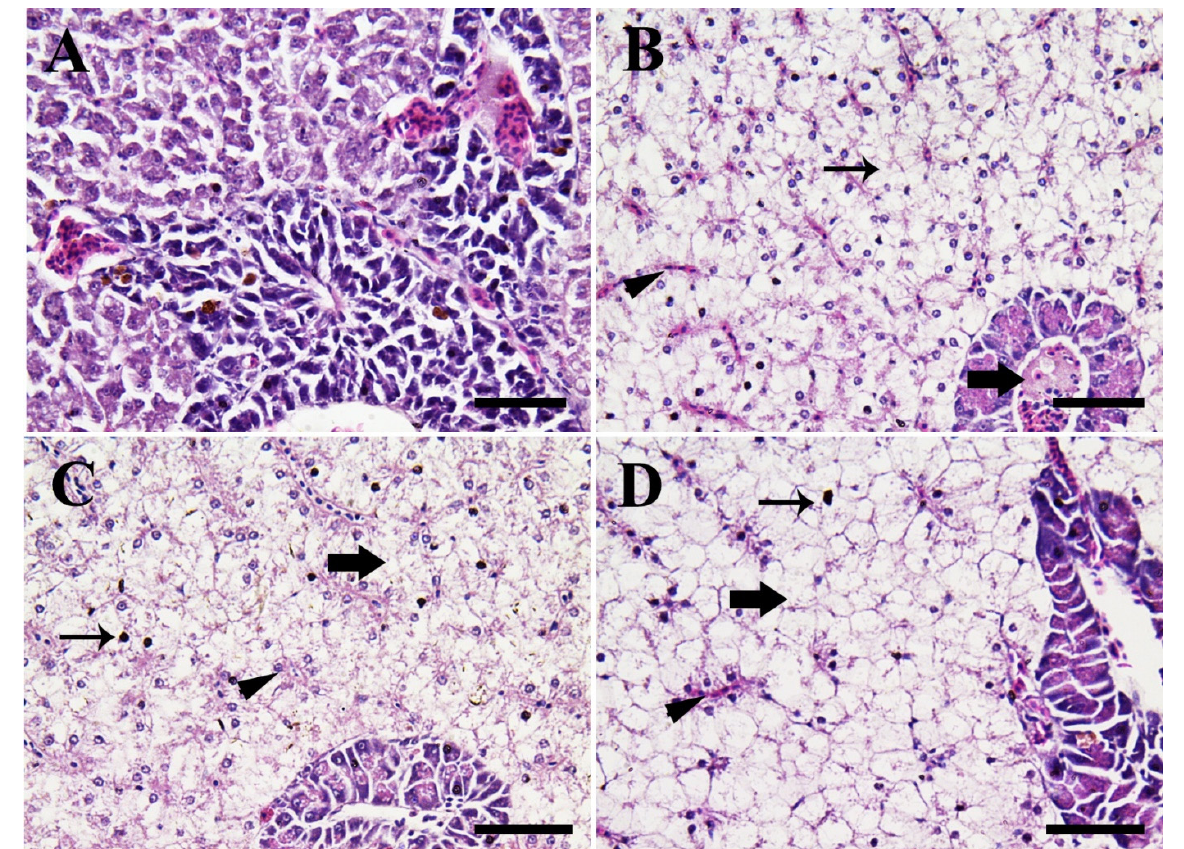
Figure 8. Representative photomicrographs in the hepatic tissues of Nile tilapia juveniles (H & E stain, scale bar = 50 µ m) of the control group ( A ), and CuONPs-exposed fish at 10 mg/L ( B ), 20 mg/L ( C ), and 50 mg/L ( D ) values, respectively for 25 days. ( A ) shows normal hepatopancreatic architecture with a normal hepatic cord and acini of the exocrine pancreas. Meanwhile, ( B ) shows slight vascular congestion (arrowhead), diffuse fatty vacuolization in hepatocytes (thin arrow), and infiltration of mononuclear inflammatory cells was evident particularly within pancreatic acinar cells (thick arrow). ( C ) shows moderate congestion (arrowhead), diffuse fatty vacuolized hepatocytes (thick arrow), and moderate necrosis (thin arrow), and ( D ) shows severe necrosis (thin arrow), fatty degeneration of hepatocytes (thick arrow), and severe congestion of blood sinusoid (arrowhead).